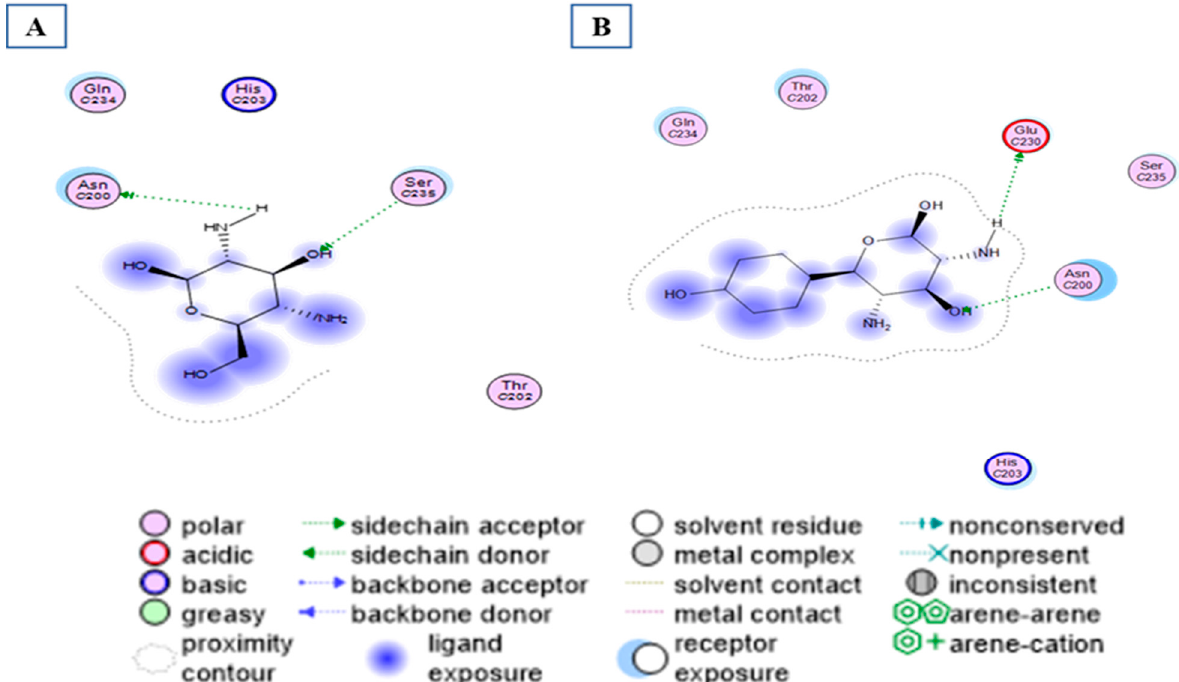
Figure 10. Di ff erent interactions of the two tested compounds with the critical amino acids in the receptor site. ( A ) Compound 3 conformer 22, and ( B ) compound 4 conformer 36.